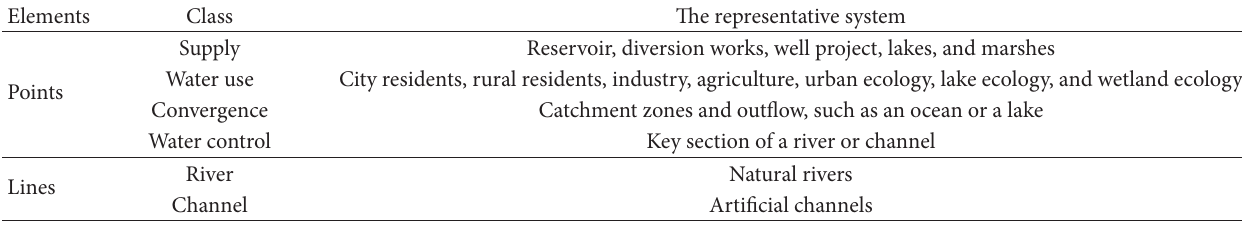
Table 1: Generalized elements of the system of water resources in AWOM.